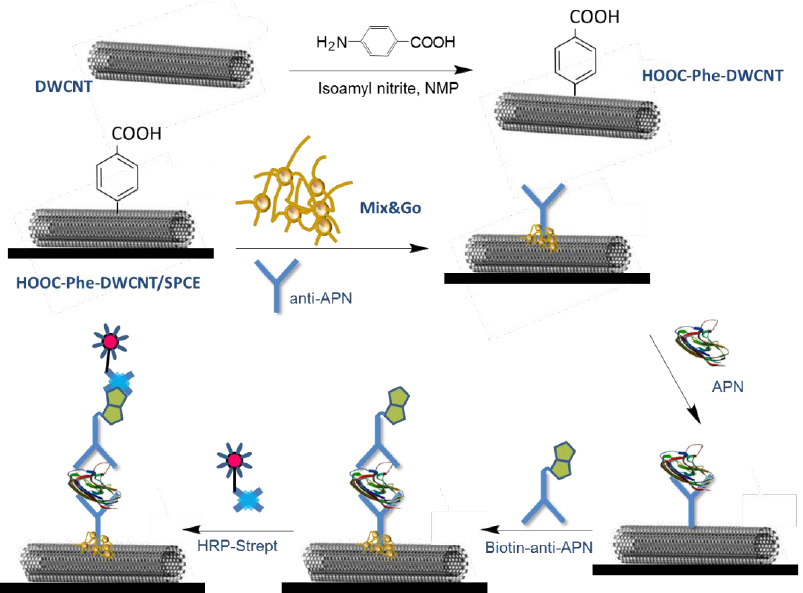
Figure 6. Schematic display of the different steps involved in the construction of an